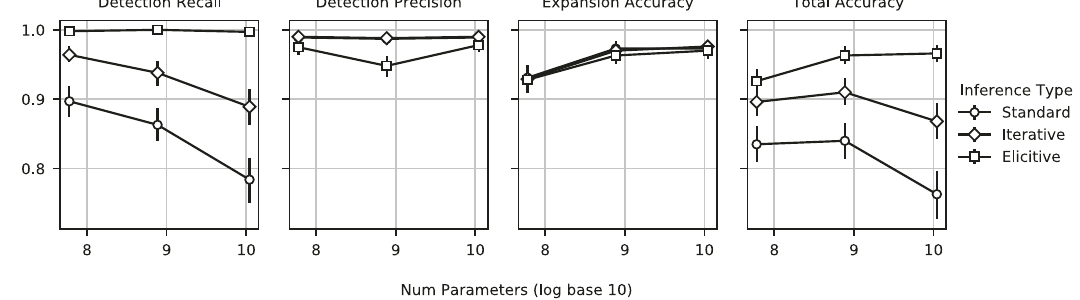
Fig. 3 | Effect of model size and inference type on performance. Model size and inference type in fl uence key model metrics on the synthetic test set. Each point re fl ects a T5 model with identical pre-training, MC-WSRS fi ne-tuning, and evalua- tion on a synthetic dataset of medical snippets. Detection recall decreases as the model size increases. However, performance is substantially and statistically improved with inference chaining techniques such as iterative inference and eli- citive inference. The inference types and model sizes do not signi fi cantly affect detection precision (percentage of the text identi fi ed as abbreviations that are